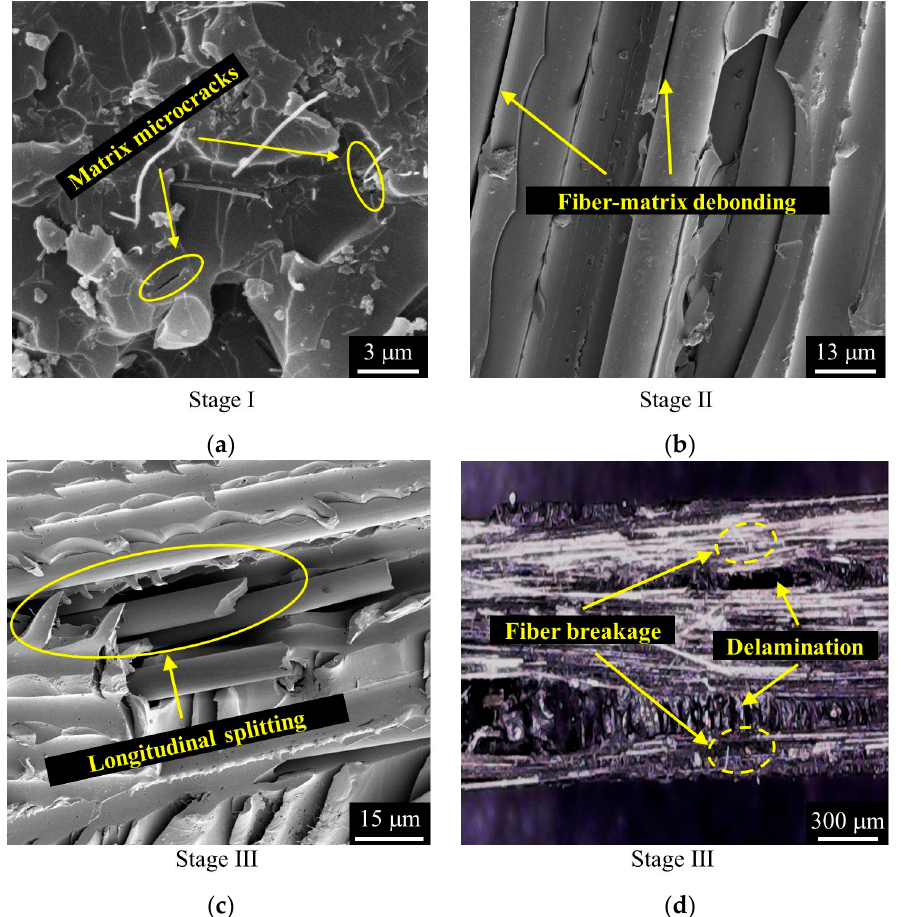
Figure 8. SEM and optical morphologies of damage initiation and development in CNF/GFRP laminates: ( a ) matrix microcracks; ( b ) fiber-matrix interfacial debonding; ( c ) longitudinal splitting; ( d ) delamination and fiber breakage.